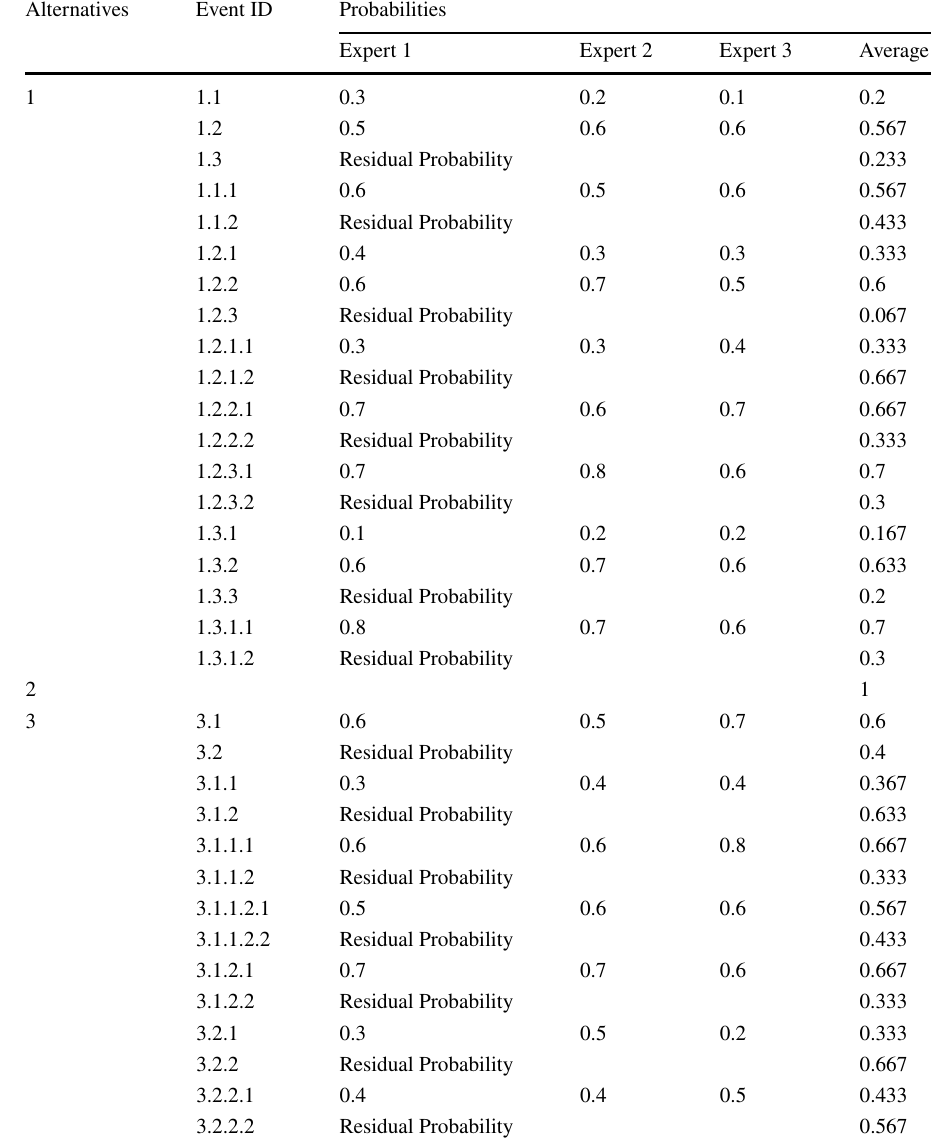
probabilities for each relevant event in a path